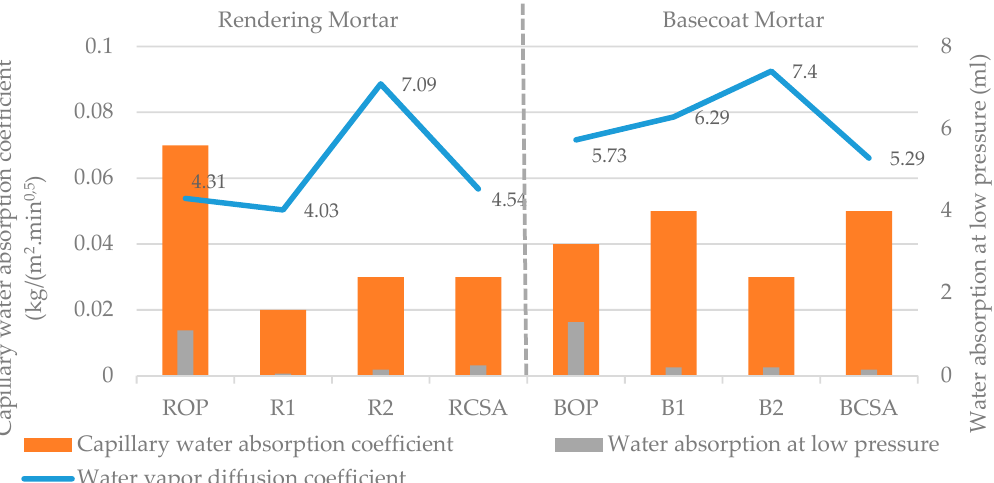
Figure 7. Water absorption coefficient due to capillary and water vapor diffusion coefficient of rendering and basecoat mortars.